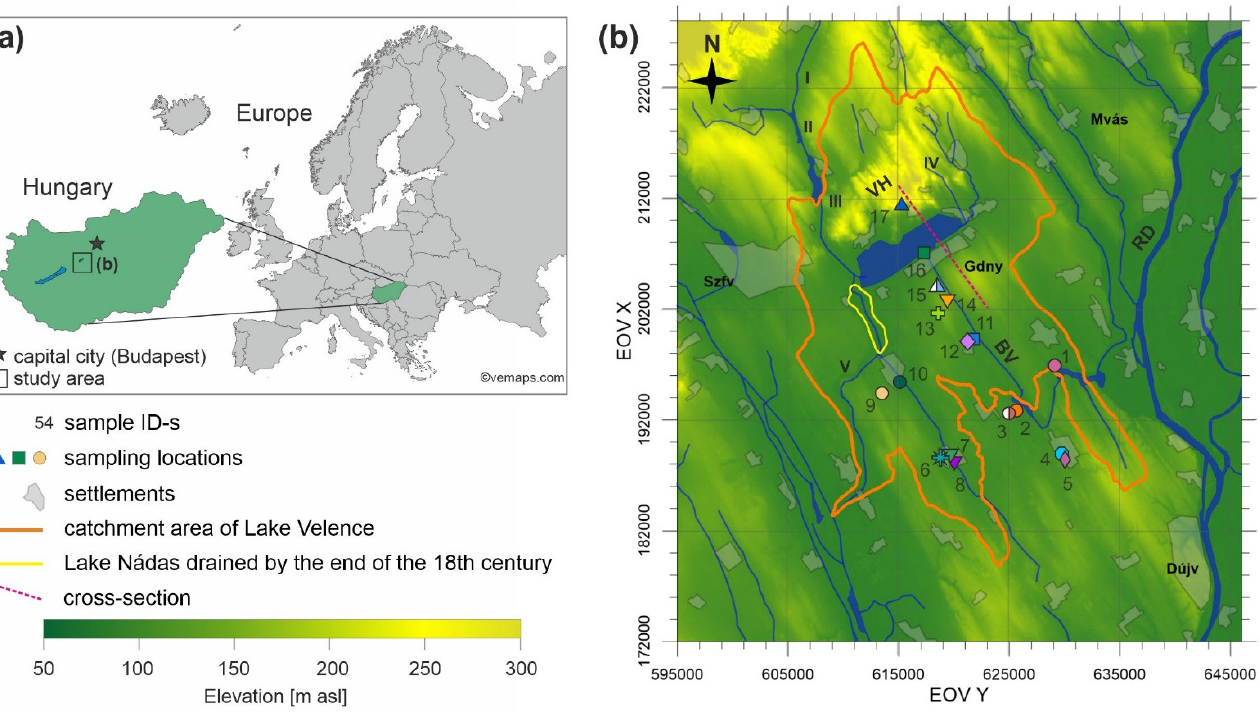
Figure 1. ( a ) The location of the study area. ( b ) Sampling locations. Main settlements: Szfv— Székesfehérvár; Gdny—Gárdony; Mvás—Martonvásárhely; Dújv—Dunaújváros. Surface water in-